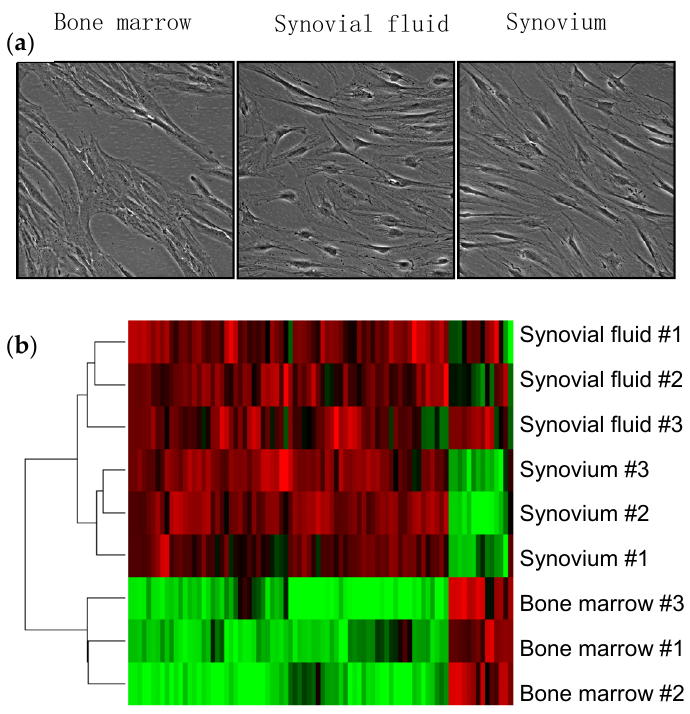
Figure 2. Comparison of synovium MSCs, synovial fluid MSCs, and bone marrow MSCs from osteoarthritis patients. ( a ) Representative morphologies. ( b ) Comparison of the gene expression profiles by hierarchical clustering analysis (reproduced from [9]).